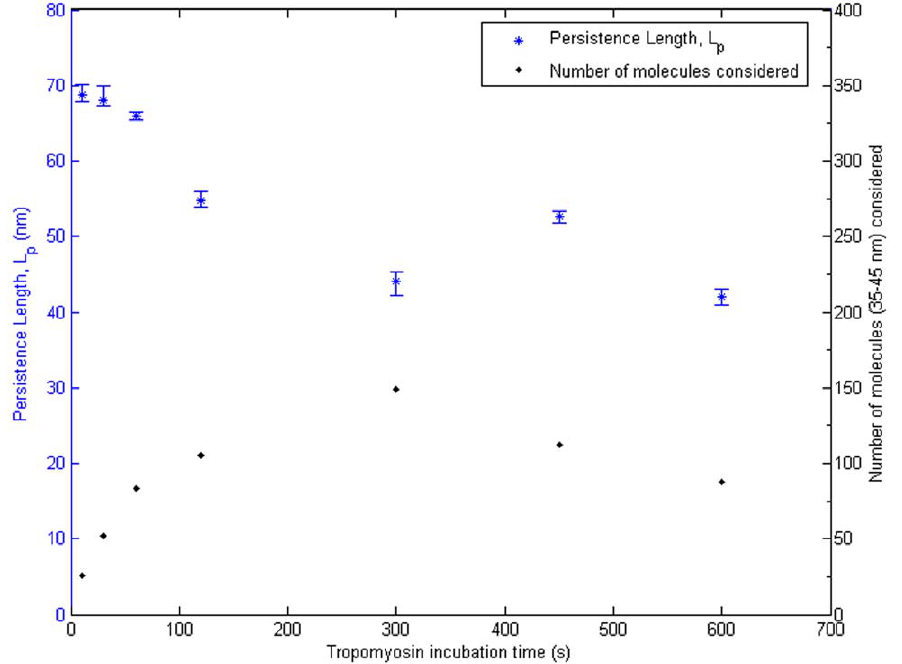
Figure 6. Deposition time study suggests L p measurements were stable with incubation time of 300 s or longer. L p values obtained by tangent angle correlation analysis (blue asterisks, left axis) and the corresponding number of molecules considered (black dots, right axis) were plotted against incubation times. An overestimation of L p was observed at incubation times below 300 s, which may be due to the shorter incubation time and/or smaller number of molecules available for the analysis. L p measurements were stable at incubation times above 300 s, where variation was comparable to the inherent uncertainty in our methodology. This implies an incubation time of 300 s was sufficient for surface equilibration of a Tm on p-Lys coated mica substrate.